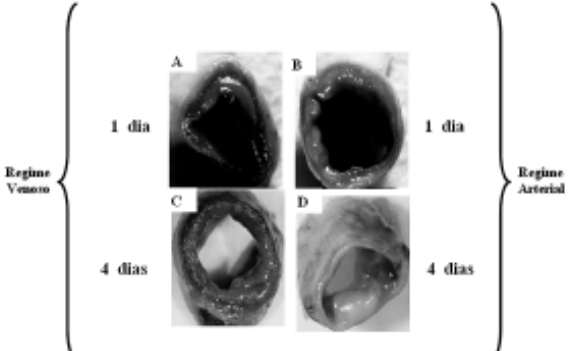
Fig. 6 - Pesquisa de viabilidade tecidual pela coloração MTT em segmentos de veia safena cultivados por um (A,B) e quatro (C,D) dias. Observa-se presença de células viáveis em toda parede vascular quando cultivada em regime pressórico venoso (A,C). As veias do grupo sob regime arterial (B,D) apresentam porções não coradas pelo MTT, sugerindo morte celular nessas regiõe s